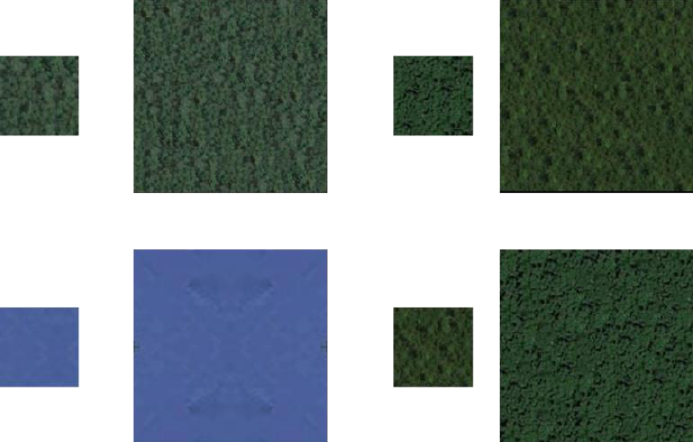
Figure 6. Results of texture synthesis; the smaller ones are samples selected from the data set and the bigger ones are the synthesized texture images.